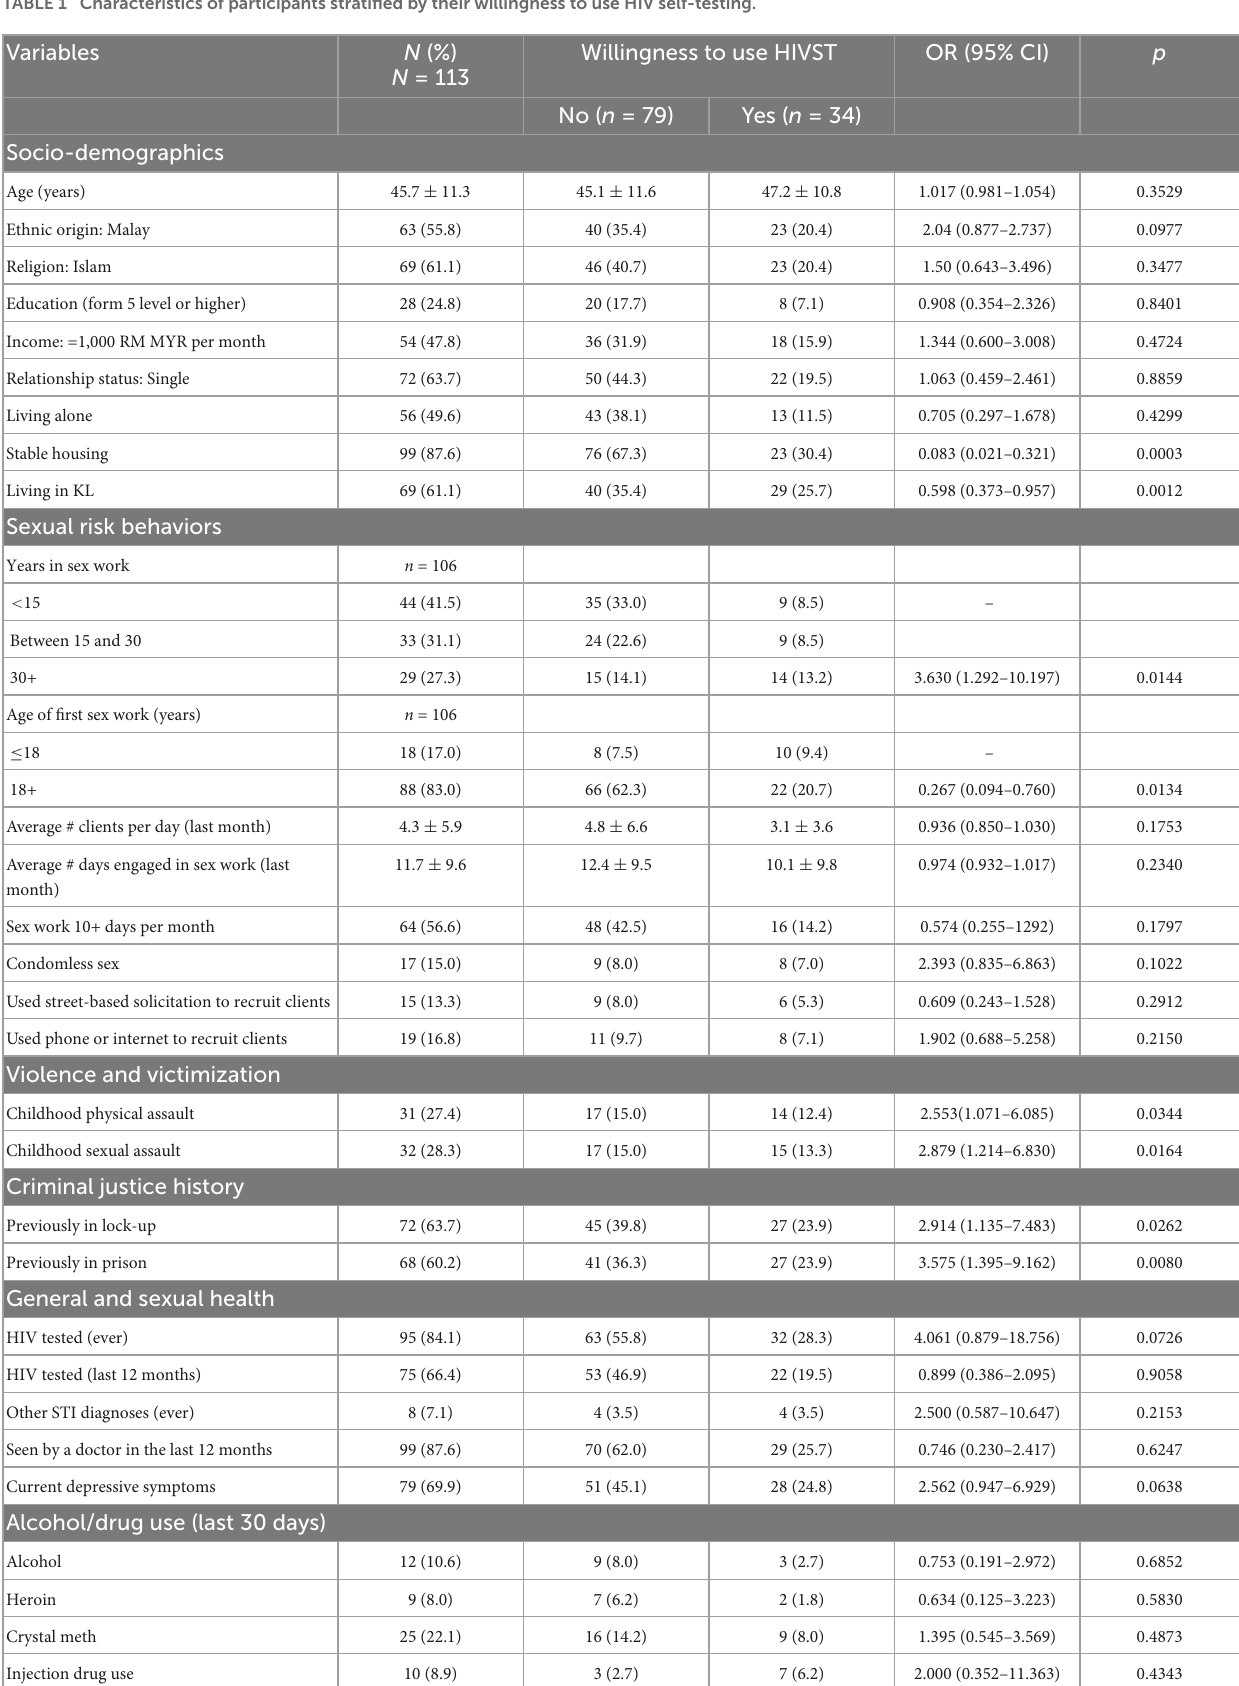
TABLE 1 Characteristics of participants stratified by their willingness to use HIV self-testing.